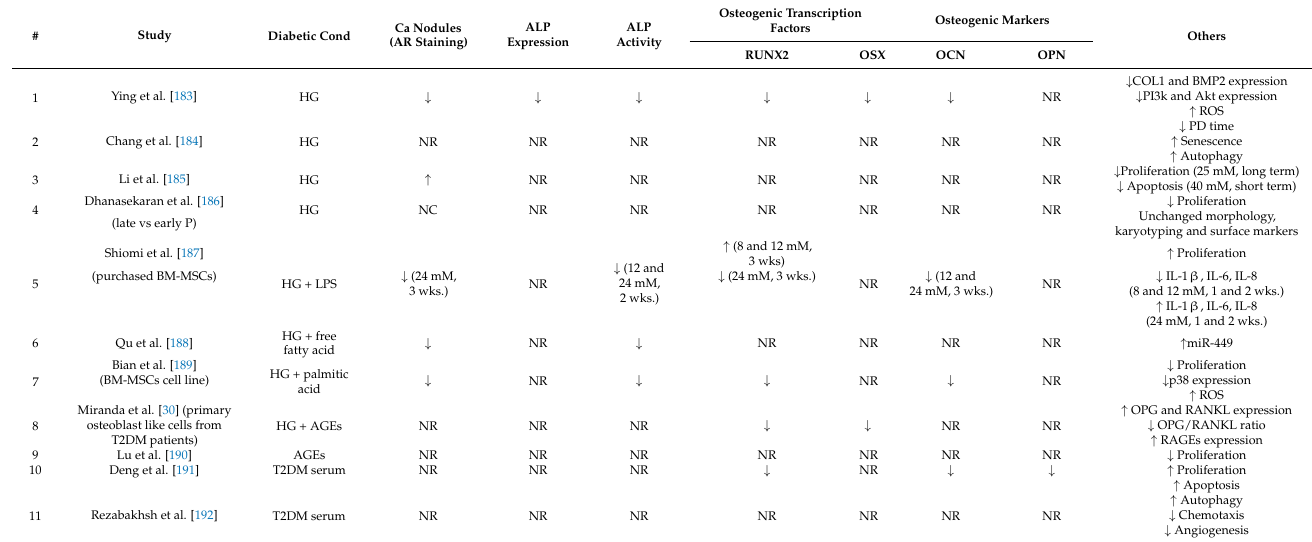
( ↓ ): reduced compared to control culture media. ( ↑ ): increased compared to control culture media. AGEs: advanced glycation endproducts. ALP: alkaline phosphatase. AR: Alizarin red. BMP2: bone morphogenic protein 2. BSP: bone sialoprotein. COL1: collagen 1. HG: high glucose. IL-1 β : interleukin 1 β . IL-6: interleukin 6. IL-8: interleukin 8. LPS: lipopolysaccharides. NC: no change. NR: not reported. OCN: osteonectin. OPG: osteoprotegerin. OPN: osteopontin. OSX: osterix. PD: population doubling. RAGEs: receptors of advanced glycated endproducts. RANKL: receptor activator NF-k β ligand. ROS: reactive oxygen species. Runx2: Runt related transcription factor 2. T2DM: type 2 diabetes